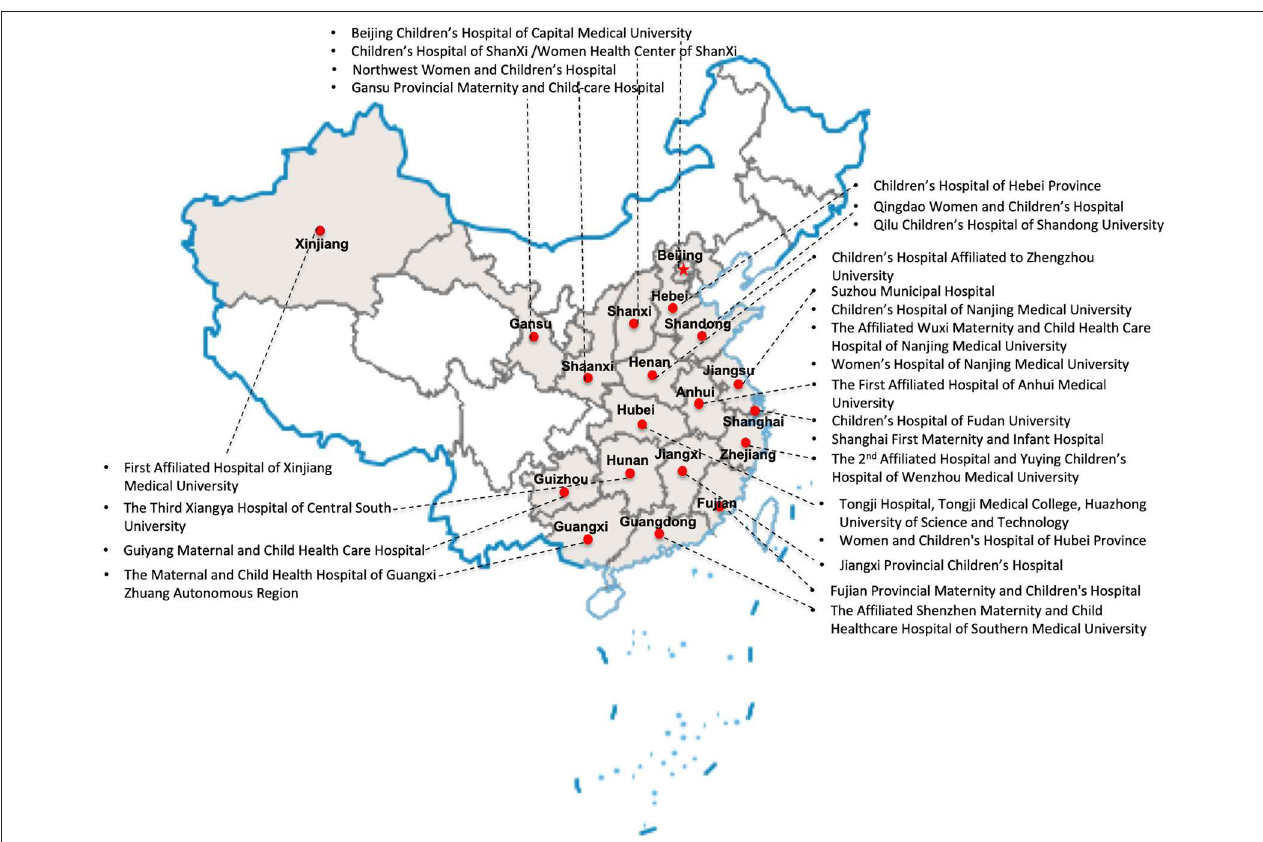
FIGURE 1 | Locations of participating